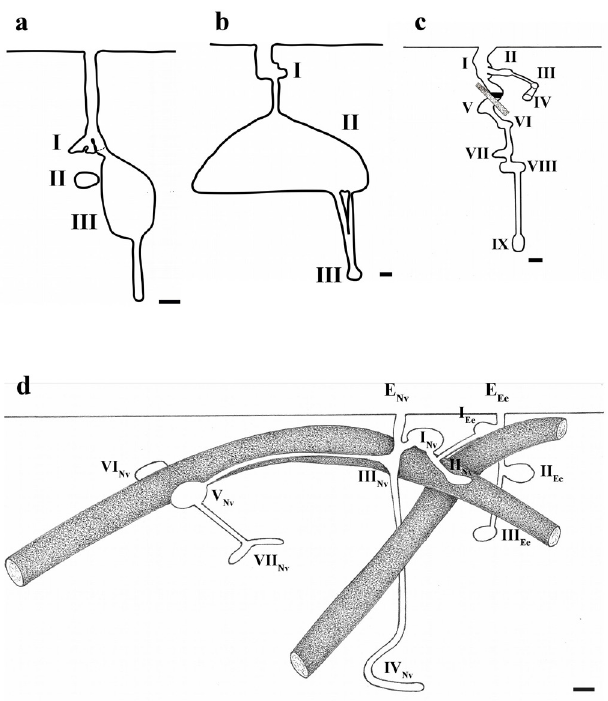
Fig 2 . Neoponera verenae 's nest architecture. a: Nv5, b: Nv6, c: Nv7, d: Nv8. E : Entrance to the chambers where Neoponera Nv verenae individuals were found. E : Entrance to the chambers where Ee Ectatomma edentatum individuals were found. Scales 2